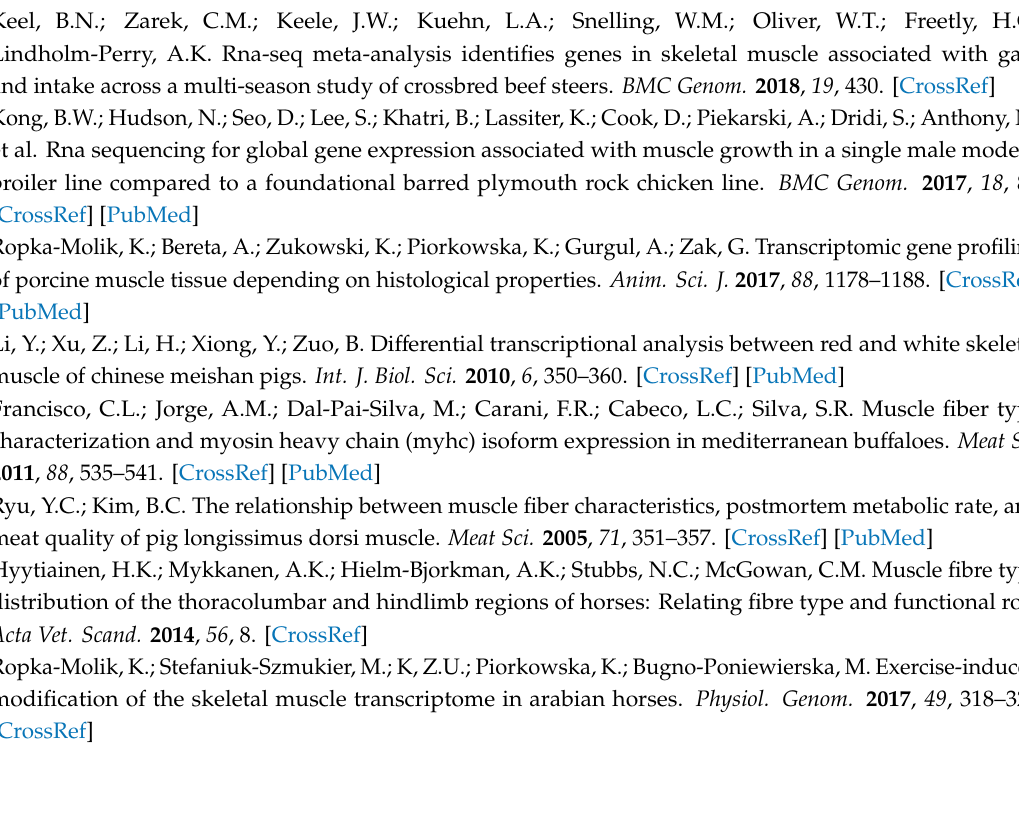
Figure S1: Optimal number of clusters for k-means clustering, Figure S2: IPA Summary network of Group A vs. Group B, Table S1: GO biological process of up-regulated DEGs in Group A vs. Group B, Table S2: GO biological process of up-regulated DEGs in Group A sub-clusters, Table S3: GO biological process of down-regulated DEGs, Table S4: GO biological process of up-regulated DEGs in Group B